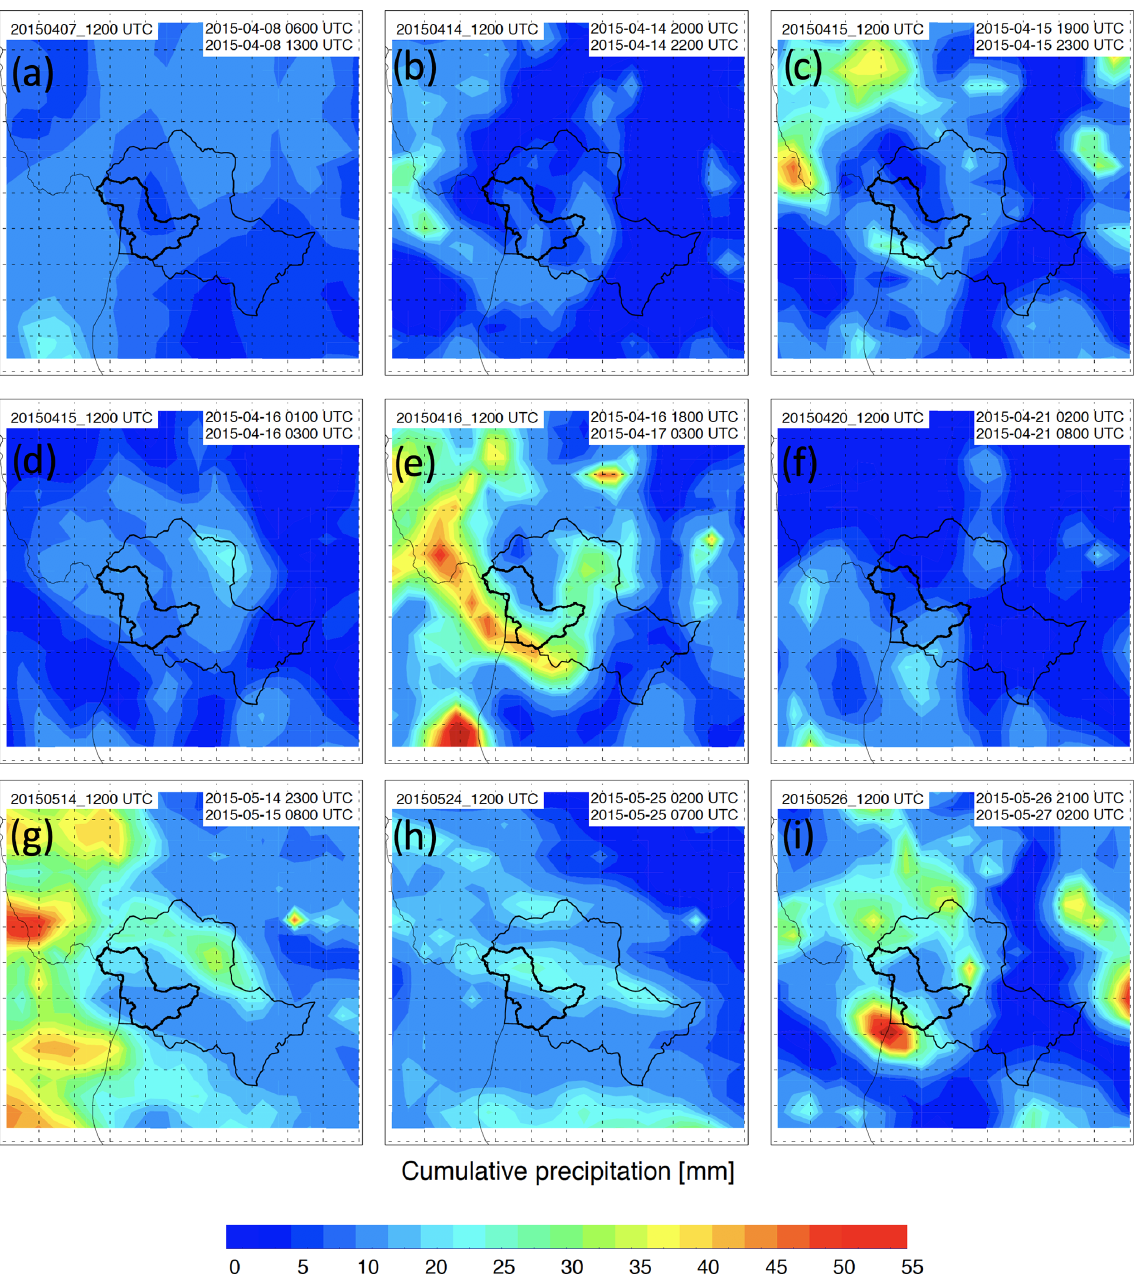
Figure A1. Spatial distribution of WRF-forecasted cumulative precipitation (24h lead time) over the region of interest for nine different rainfall events during the April–May 2015 rainy season: (a) from 8 April 2015 06:00 to 13:00UTC, (b) from 14 April 2015 20:00 to 22:00UTC, (c) from 15 April 2015 19:00 to 23:00UTC, (d) from 16 April 2015 01:00 to 03:00UTC, (e) from 16 April 2015 18:00UTC to 17 April 2015 03:00UTC, (f) from 21 April 2015 02:00 to 08:00UTC, (g) from 14 April 2015 23:00UTC to 15 April 2015 08:00UTC, (h) from 25 May 2015 02:00 to 07:00UTC, and (i) from 26 May 2015 21:00UTC to 27 May 2015 02:00UTC. While some of the cases exhibit orographic intensification, the panels show significant interevent variability despite their similar synoptic flow (not shown), with no fixed orographic pattern indicating intensification at Cerro